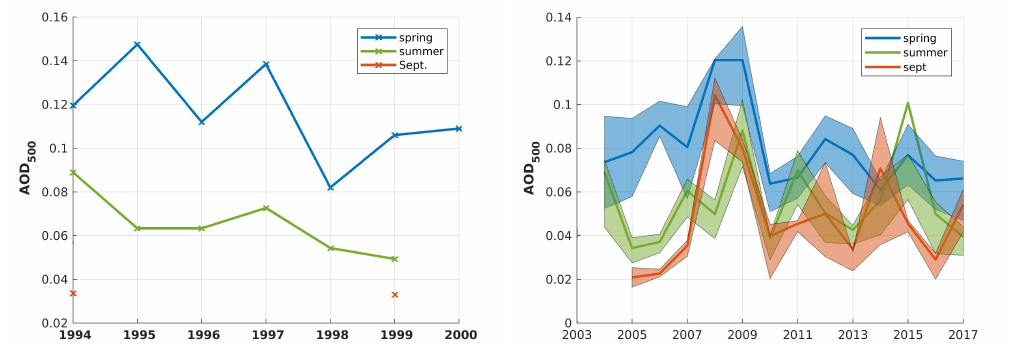
Figure 7. Left: Monthly mean AOD 500 for the years 1994–2000 (already published in Herber et al. [13]). Right: Seasonal means of the AOD of “spring” (March and April), “summer” (July to August), and September as the only available representative for the autumn month of the years 2004–2017. The shaded areas represent the 30th and 70th percentiles,